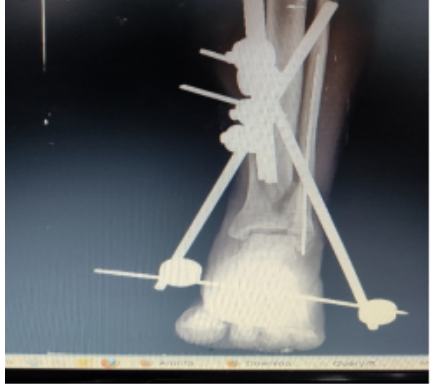
Figure 5. immediate post op x ray AP view